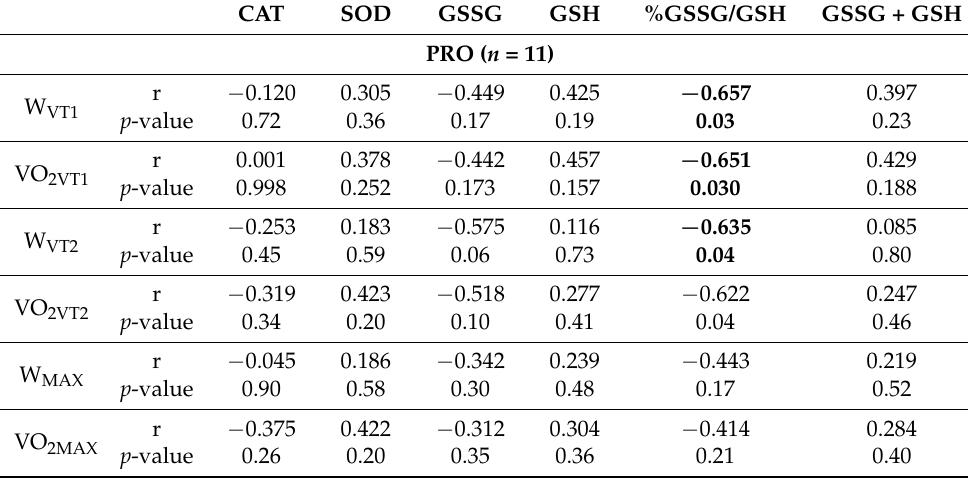
Table 4. Correlation between endogenous antioxidant enzymes and performance-metabolic variables from professional and amateur